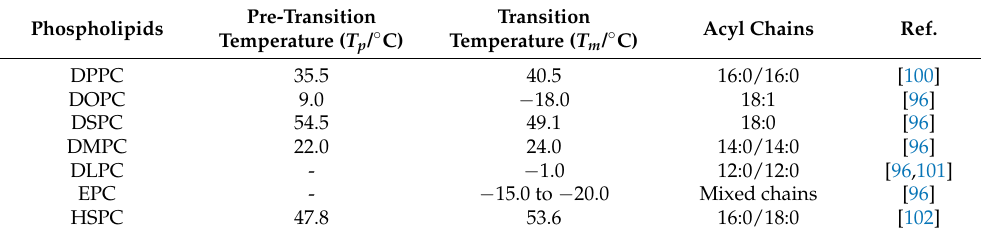
Table 2. A table showing the increasing acyl chains with increasing phase transition temperature ( T m ). Pre-Transition Transition Phospholipids Acyl Chains Ref. Temperature ( T p / ◦ C) Temperature ( T m / ◦ C) DPPC